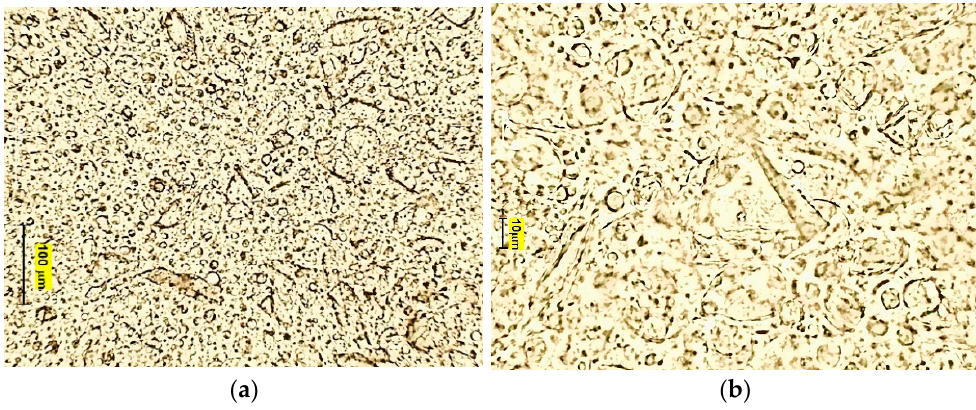
Figure 6. Microscopic image of a cream with silicone oil, sample E2, magnification ( a ) 10×, ( b ) 40×.